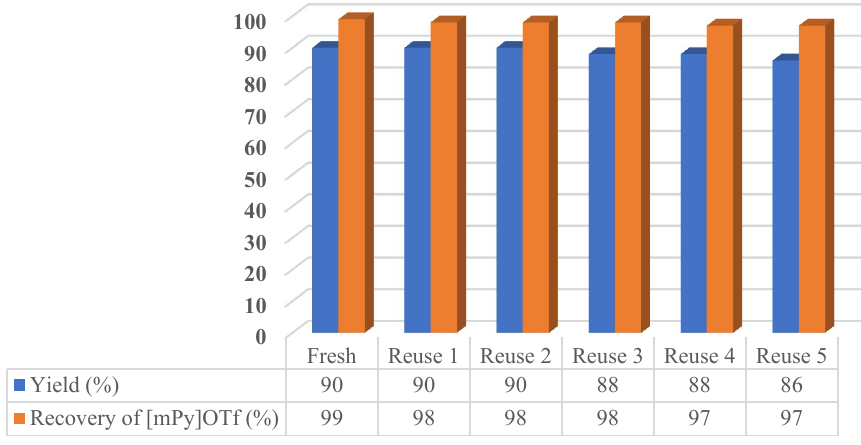
Figure 2. Recovery and reuse of [mPy]OTf until six cycles.